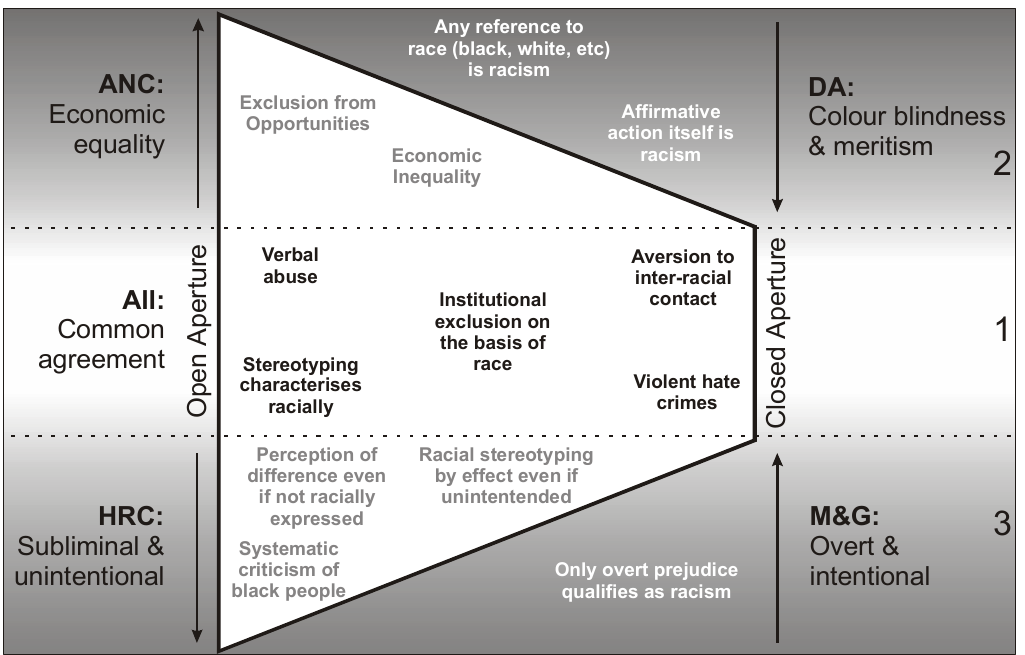
Figure 2: Dimensions of the debate over